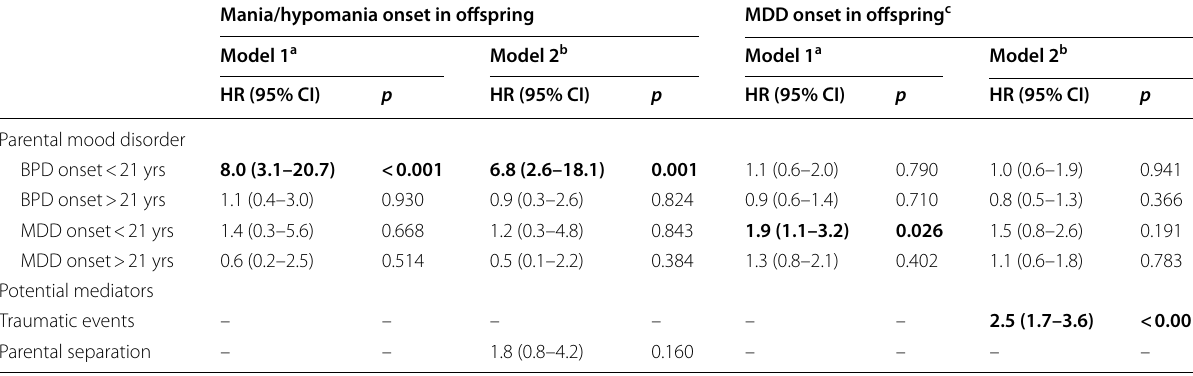
Statistically significant values are in